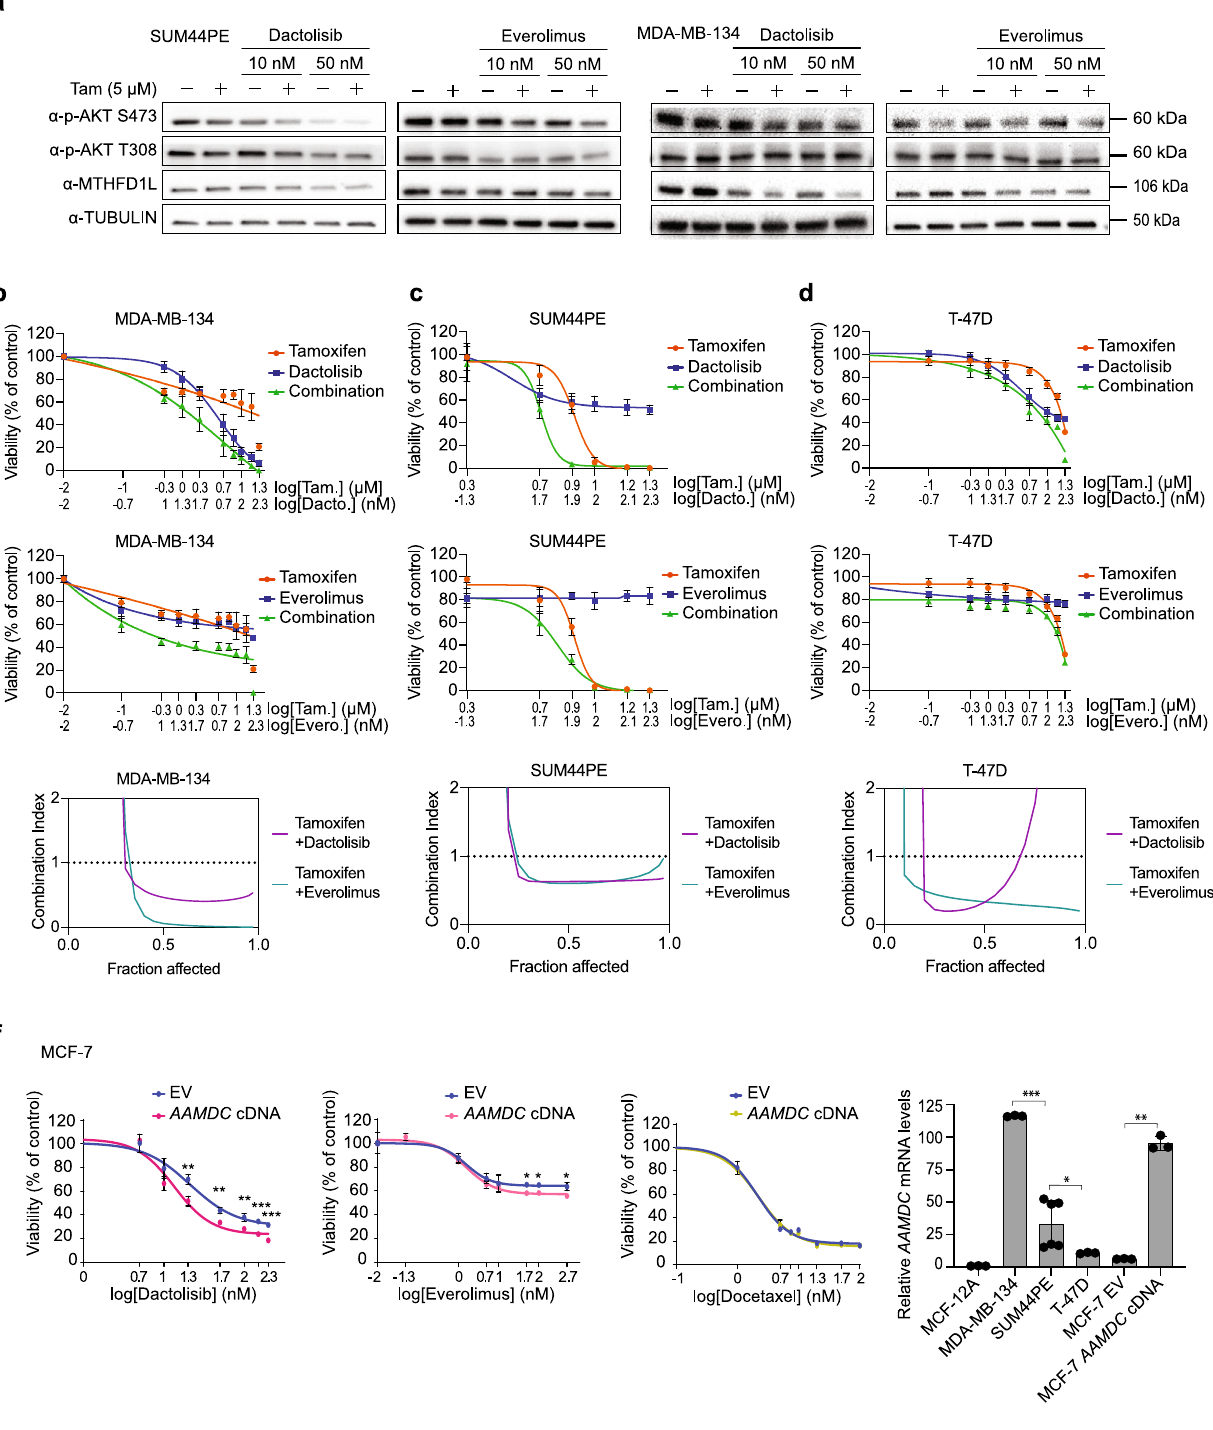
plasmid, while the RLuc8-AAMDC insert was synthesized by GeneArt and subcloned into the pcDNA3 -RLuc8 vector 56 . Lentiviral production and transduction of breast cell lines . Lentiviral particles expressing either the shRNAs or the cDNAs were generated by lentiviral trans- duction of HEK293T cells transfected with 4.5 μ g of either empty vector plasmids (pLKO.1 or pLv105, GeneCopoeia, Supplementary Data 6), pLKO.1 expressing the corresponding shRNA, or pLv105 expressing the selected cDNAs, and 1.54 μ g of pCI VSV-G Envelope plasmid, 2.88 μ g of pMDLg/pRRE (GAG/POL), and 1.1 μ g of pRSV-Rev packaging plasmids (Addgene). The DNAs were mixed with 50 μ L